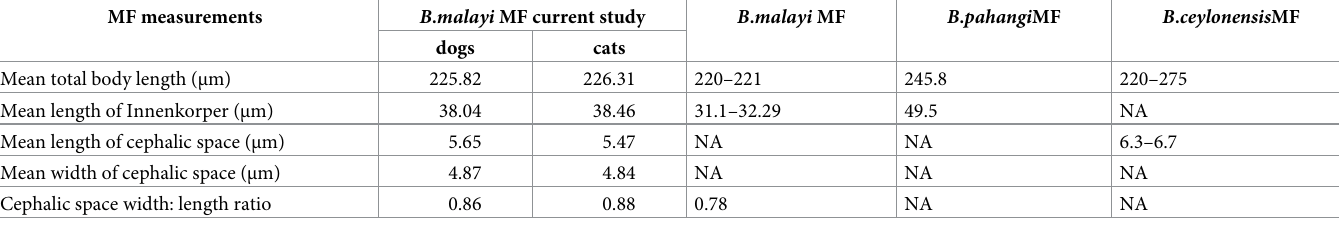
Table 1. Measurements of B . malayi microfilaria from the current survey compared with B . malayi , B . pahangi and B . ceylonensis from scientific literature a . MF measurements